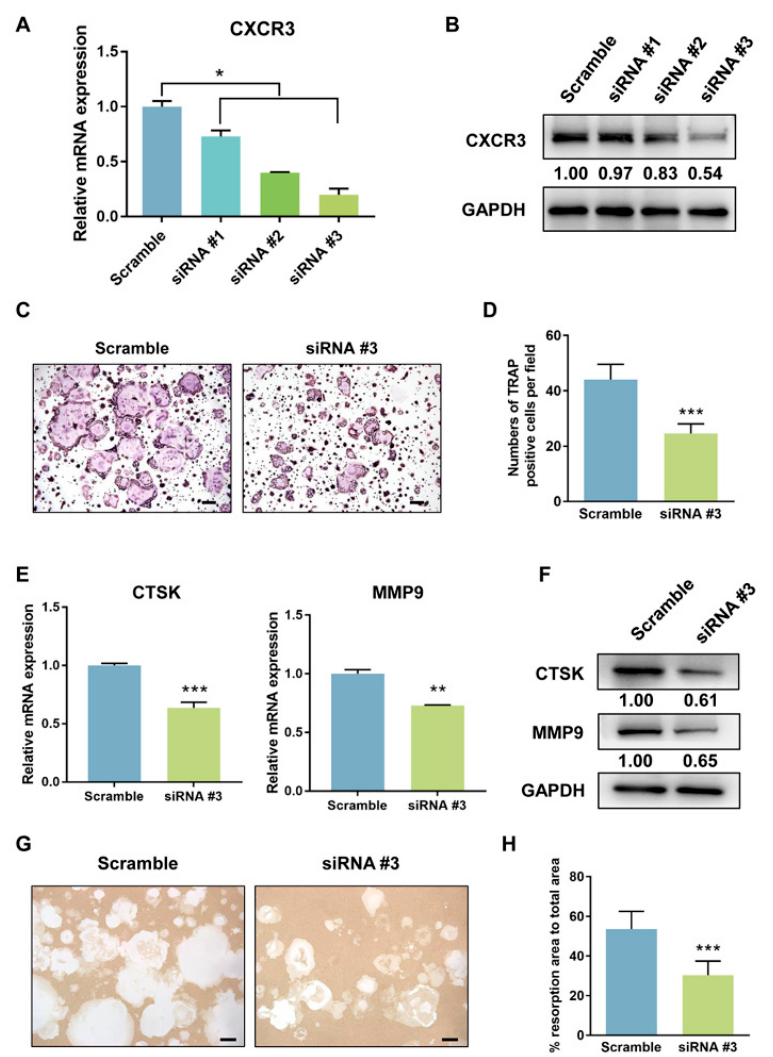
Figure 5. CXCR3 positively regulates osteoclast differentiation. The interference efficiency of the siRNAs targeting CXCR3 was detected on mRNA levels by real-time PCR ( A ) and protein levels by western blotting ( B ). ( C ) TRAP staining identified the osteoclast formation after CXCR3 knockdown. ( D ) Numbers of TRAP+ osteoclasts. Expression levels of genes related to bone resorption (CTSK and MMP9) were detected by real-time PCR ( E ) and western blotting ( F ). ( G ) Representative images of bone resorption assay after CXCR3 knockdown. ( H ) Quantification of resorption pits. Error bars represent SD. * p < 0.05, ** p < 0.01, and *** p < 0.001.